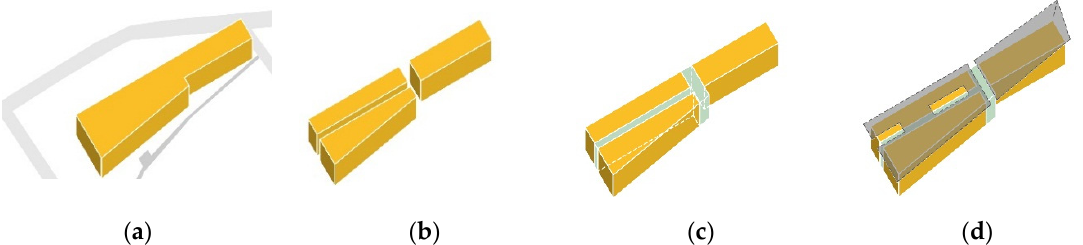
Figure 23. Diagram of the building body formation: ( a ) Adjustment of the object to the building plot after the delineation of new roads; ( b ) Division of the complex into museum, hotel and office functions; ( c ) Structural isolation of the ‘wedge’ with circulation and big groups of greenery; ( d ) Application of a flat roof and a spatial cover reminding of an aircraft wing (elaborated by E. Latusek). Buildings 2020 , 10 , x FOR PEER REVIEW 24 of 28